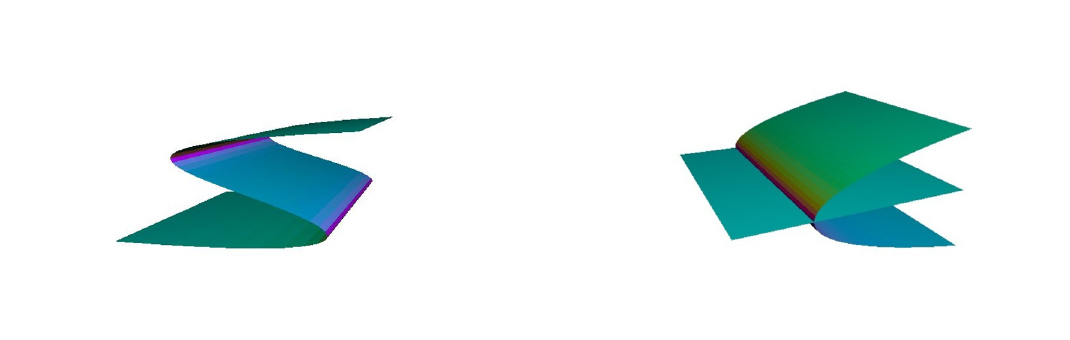
Figure 2 . Left: smooth degree three spectral cover. Right: reducible degree three spectral cover, with one component isomorphic to the base